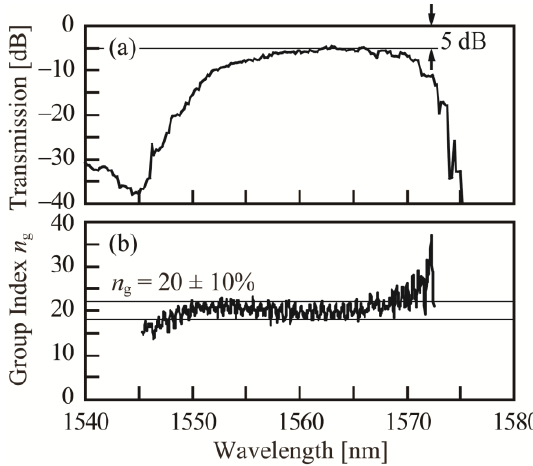
Figure 2. Slow-light characteristics of fabricated device. ( a ) Transmission spectrum; ( b ) n g spectrum.